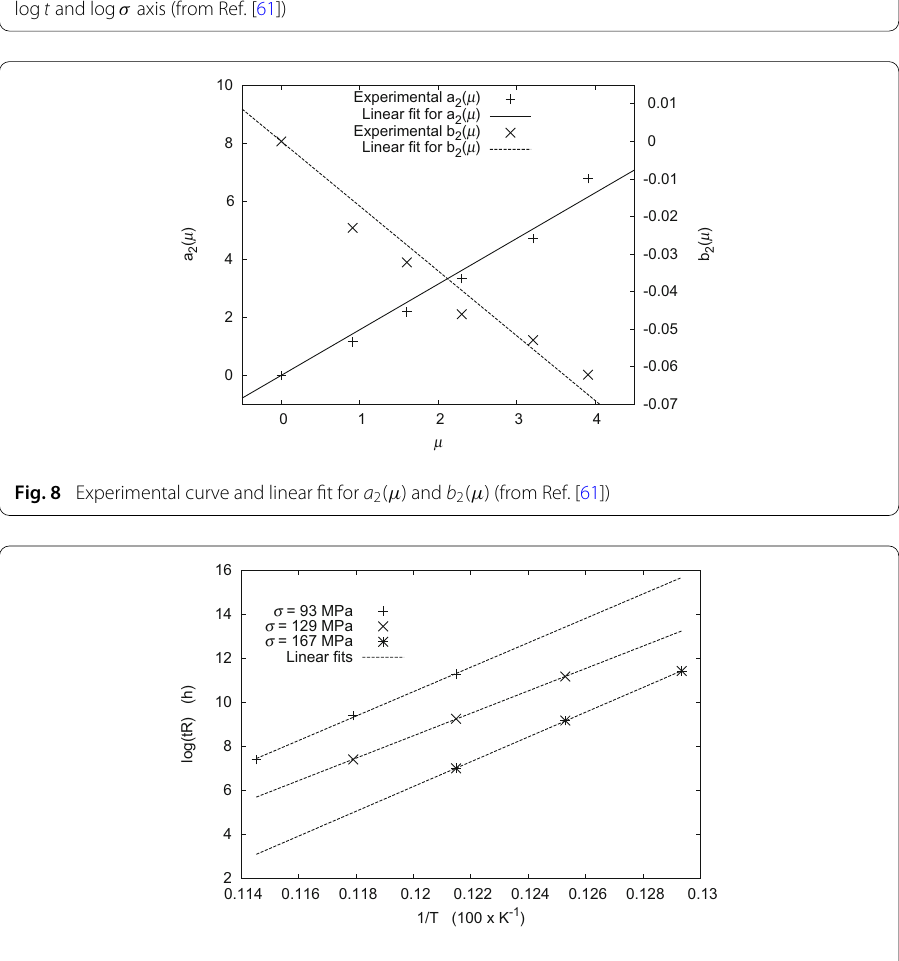
Fig. 9 Experimental responses log( t R ) vs. 1 / T at different stress levels (Ref.